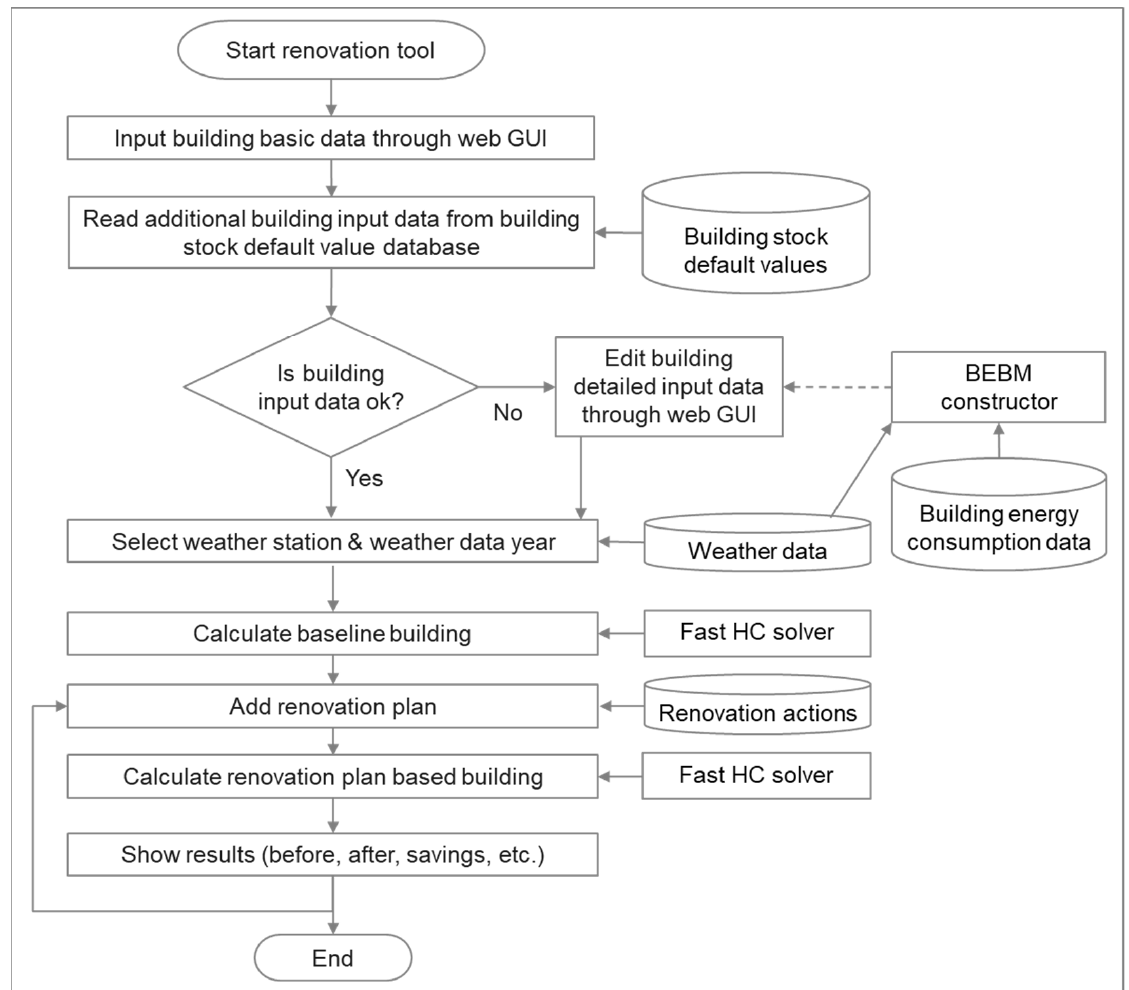
Figure 4. The steps for using the retrofitting tool via web GUI.